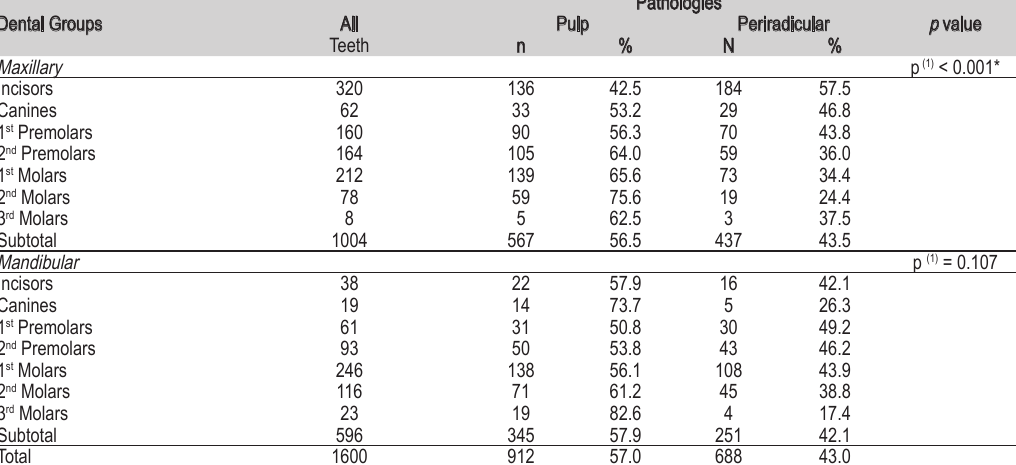
Table 3 - Prevalence of treated teeth due to pulp and periradicular pathologies according to dental